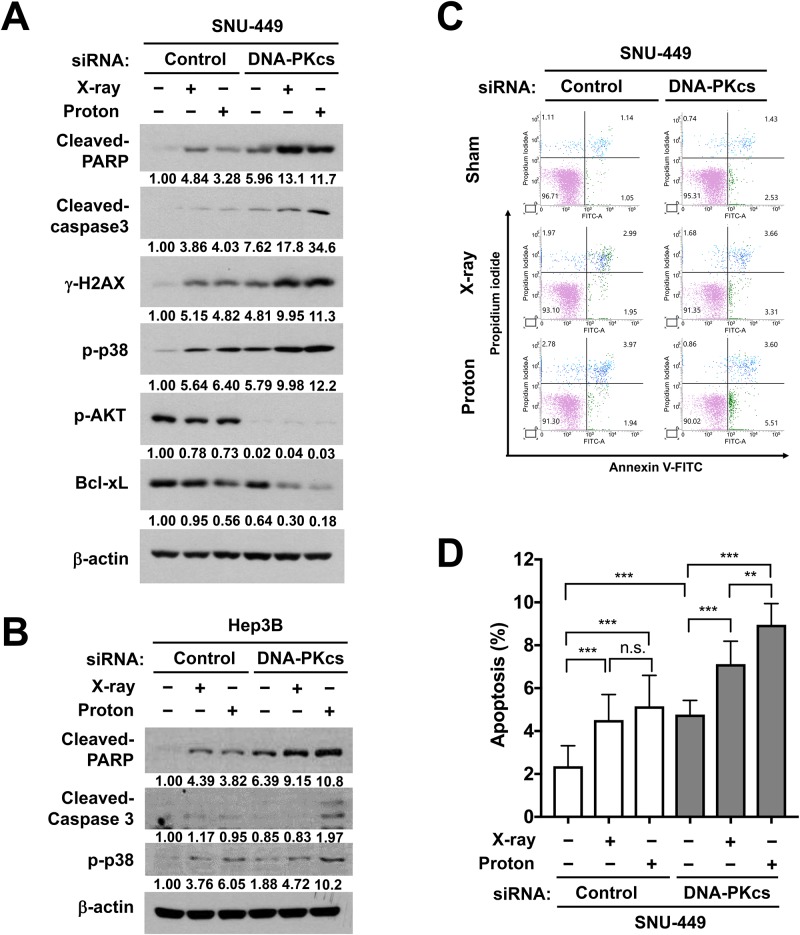
Depletion of DNA-PKcs increases proton sensitivity of HCC cells via induction of apoptosis.(A) Western blot shows induction of apoptotic markers by combination treatment with DNA-PKcs siRNA and protons in SNU449 cells. The siRNA-transfected cells were harvested 72 post-irradiation with 6 Gy of X-rays or protons. Expressions of cleaved-PARP, cleaved-caspase 3 and phopho-p38 were used as markers for apoptosis induction. Bcl-xL and phopho-AKT were used as pro-survival markers. β-actin was used as a loading control. Relative band intensity was normalized to β-actin. (B) DNA-PKcs depletion enhanced proton-induced apoptosis in Hep3B cells. The samples were prepared as described above. β-actin was used as a loading control. Relative band intensity was normalized to β-actin. (C) Flow cytometry histograms showing induction of apoptosis by combination with DNA-PK siRNA and protons. The siRNA-transfected SNU-449 cells were irradiated with 6 Gy of X-rays or protons and were harvested at 72 h. Apoptosis was assessed by flow cytometry with annexin V and PI co-staining. (D) Quantification of apoptosis shows that DNA-PK siRNA enhanced proton-induced apoptosis, compared to control-siRNA. Data represent mean ± SD from two independent experiments. **p < 0.01; ***p < 0.001; n.s.: not significant.